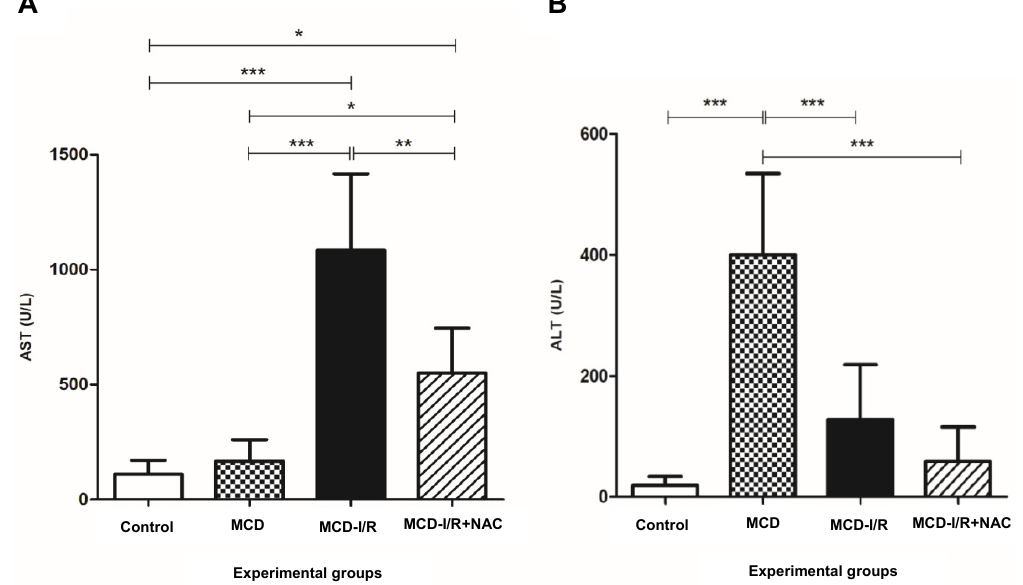
Figure 1. Levels of hepatic enzymes in the liver of normal mice and of animals submitted to ischemia / reperfusion (I / R) in the methionine- and choline-deficient (MCD) diet treated or not with N -acetylcysteine (NAC). The figure shows the levels of ( A ) aspartate aminotransferase (AST) and ( B ) alanine aminotransferase (ALT) (* p < 0.05, ** p < 0.01, and *** p < 0.001; N = 5–6; Bonferroni one-way ANOVA).